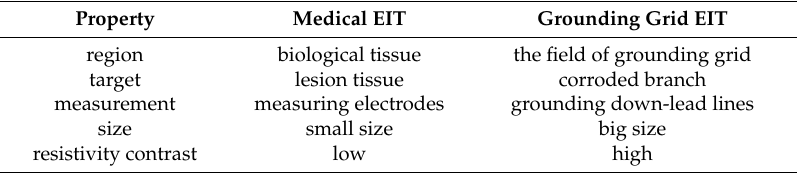
Table 1. Comparison between medical EIT and grounding grid